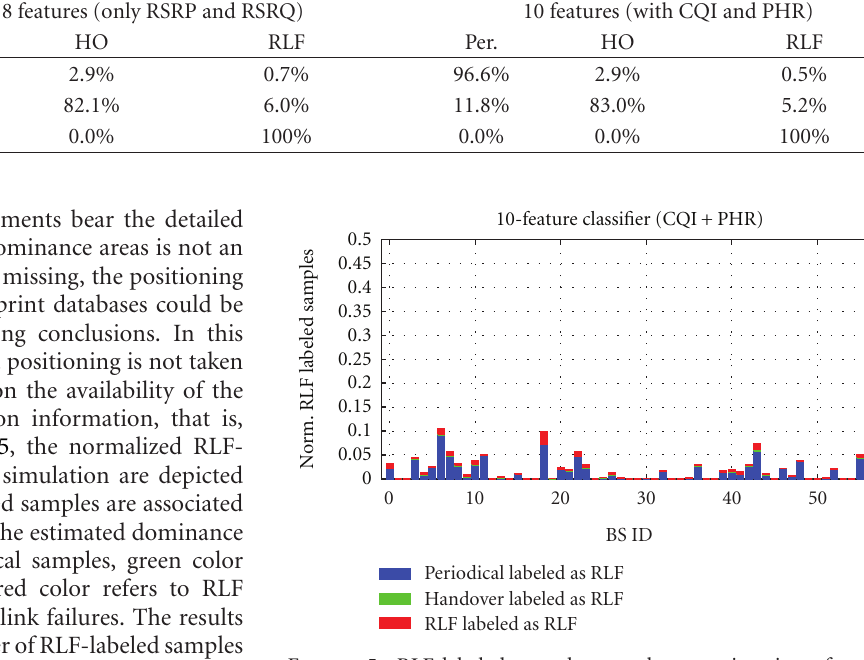
Figure 5: RLF-labeled samples per base station in reference